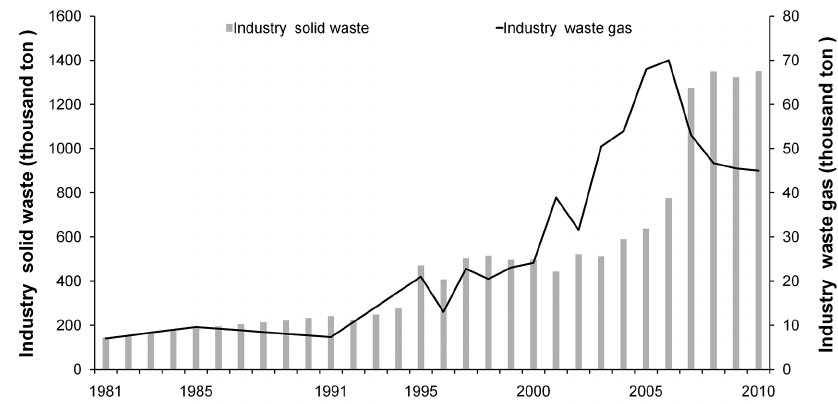
Figure 11. Environmental pollution change in Xiamen